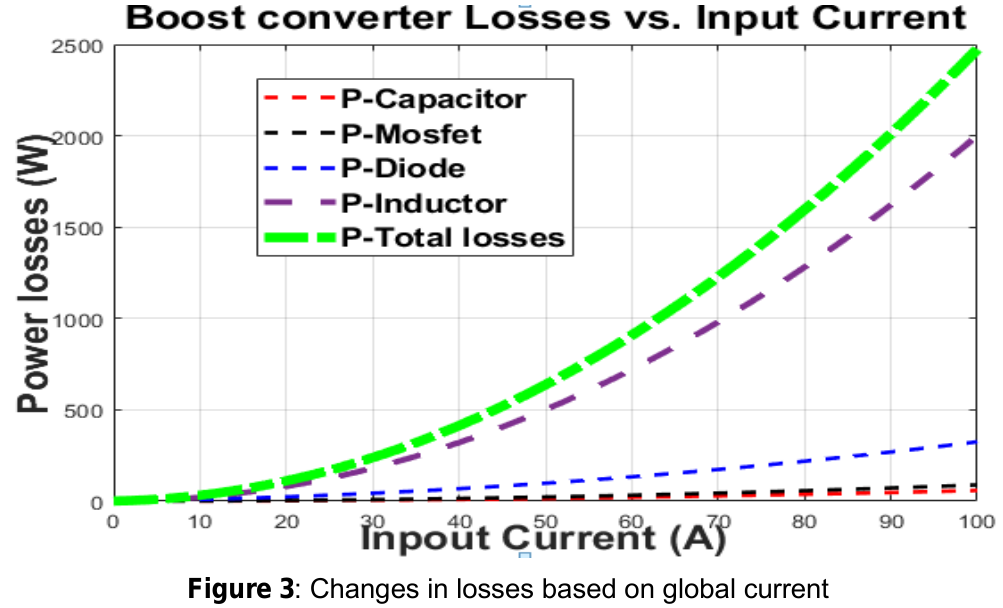
Figure 3 : Changes in losses based on global current